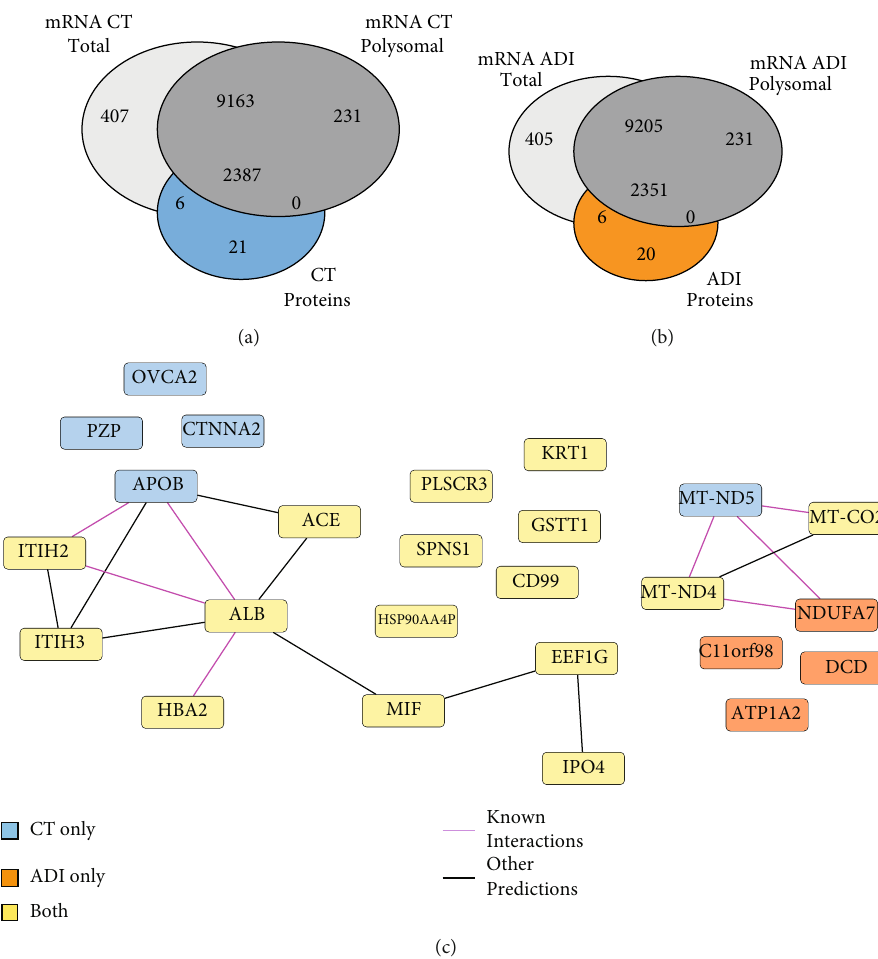
Figure 3: Unseen genes in the transcriptome are revealed by proteomics. (a) Venn diagram comparing all proteins and total mRNAs identi fi ed in the CT (left Venn diagram) and ADI (right Venn diagram) conditions. (b) Venn diagrams comparing all proteins and polysomal mRNAs identi fi ed in the CT (left Venn diagram) and ADI (right Venn diagram) conditions. Boxes show hidden proteins detected exclusively in the CT (5 proteins) and ADI (4 proteins) conditions. (c) Protein-protein interaction network demonstrating the identi fi ed hidden proteins. CT represents undi ff erentiated hASC, ADI represents 24h-di ff erentiated cells, and BOTH represents total and polysomal